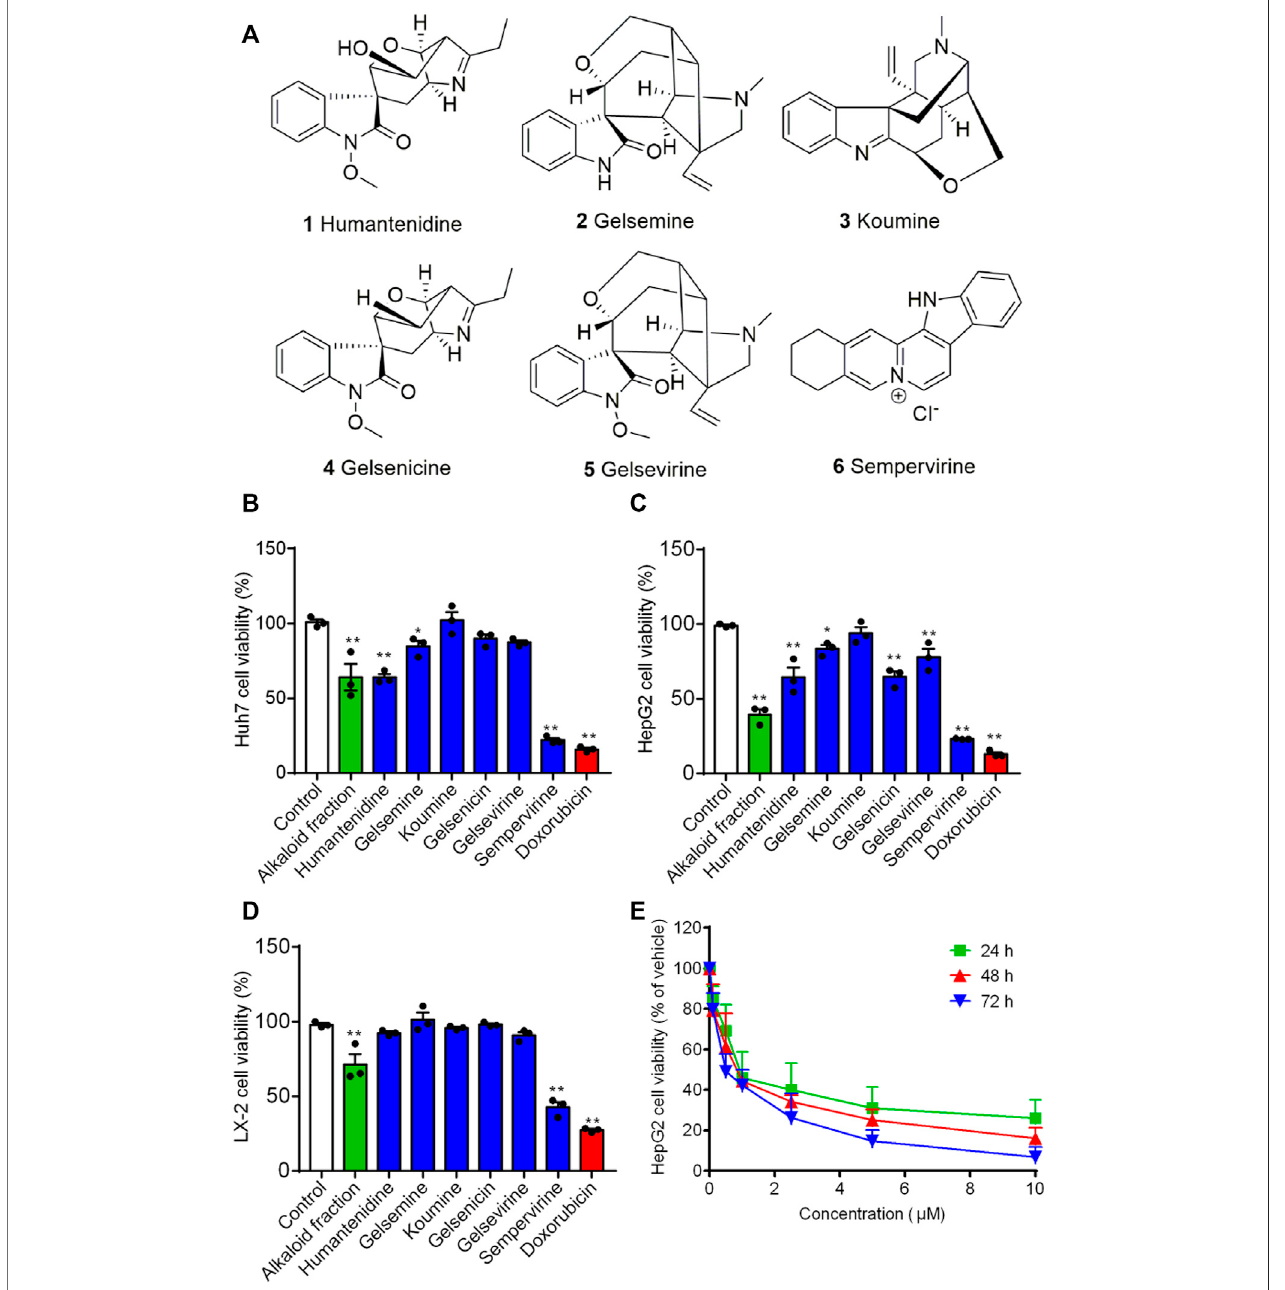
FIGURE2| Theeffectofalkaloidsongrowth-inhibitingactivityinHepG2,Huh7andLX-2cells. (A) Thechemicalstructureofalkaloids.Huh7 (B) HepG2 (C) andLX- 2 (D) cellsweretreatedfor24 h.CellviabilitywasassayedbyCCK8. (E) Sempervirine(0,0.1,0.5,1,2.5,5,10 μ M)inhibitedHepG2cellsgrowthfor24,48,and72 h* p < 0.05; ** p < 0.01 vs .